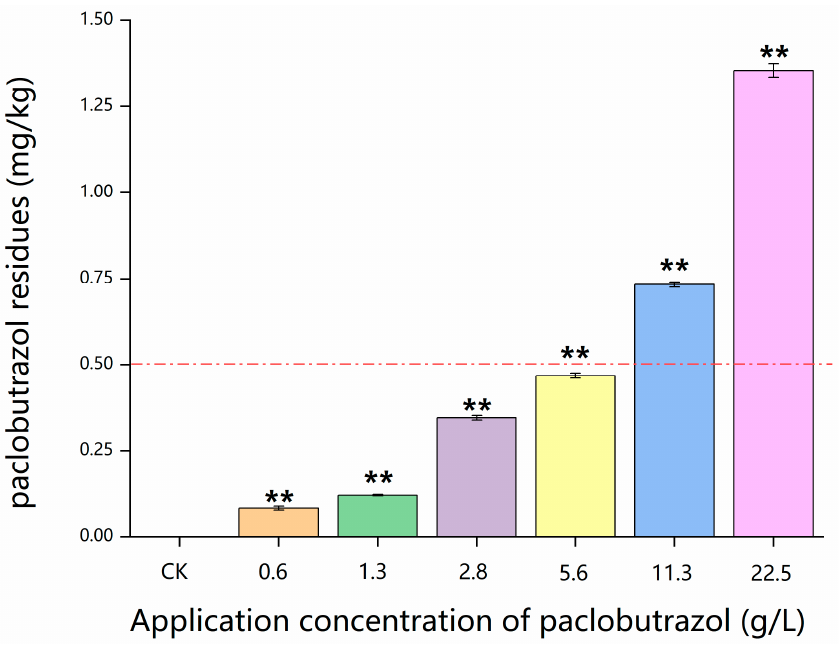
Figure 1. The final residues of paclobutrazol in O. japonicus after spraying different concentrations of paclobutrazol. Data are mean ± SD, n = three; ** p < 0.01, versus CK group (one-way ANOVA with Tukey’s multiple comparison test). Vegetables and fruits MRL = 0.5 mg/kg in GB 2763-2019.